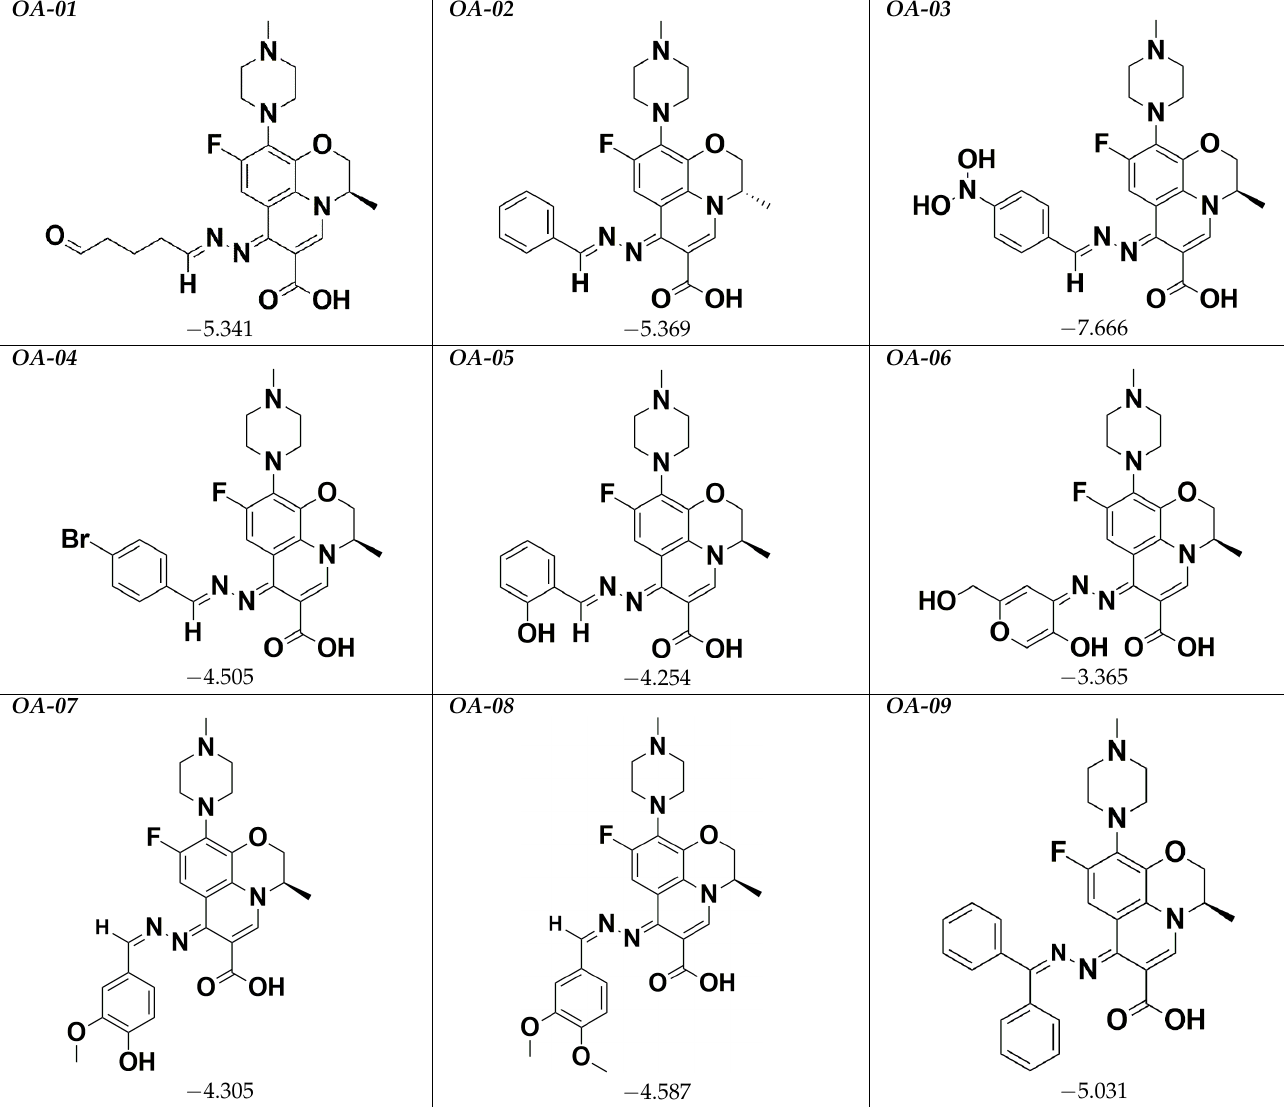
Table 2. The glide scores of the OA series compounds with corresponding structures.